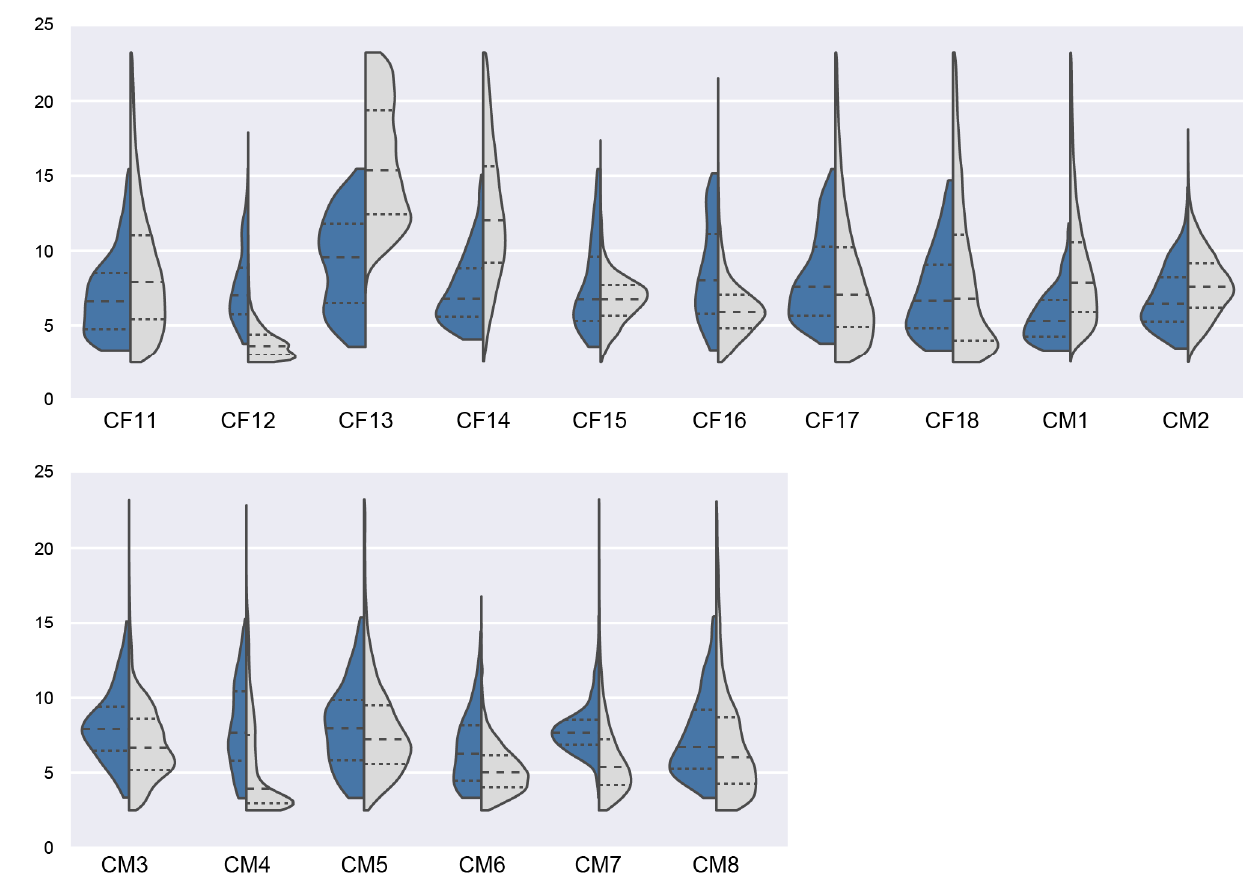
Figure A2. Split-violin plots comparing laboratory (left distribution) and ambulatory (right distribution) estimates of Ps for each vocally typical participant.